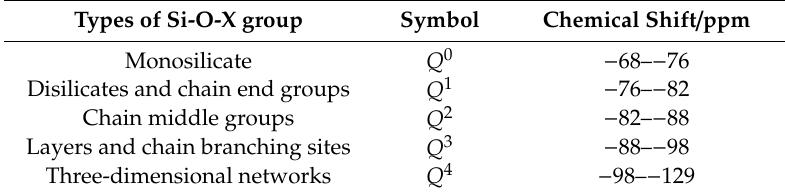
Table 4. 29 Si NMR chemical shifts of the structure unit of Q n in solid silicates [28]. Types of Si-O-X